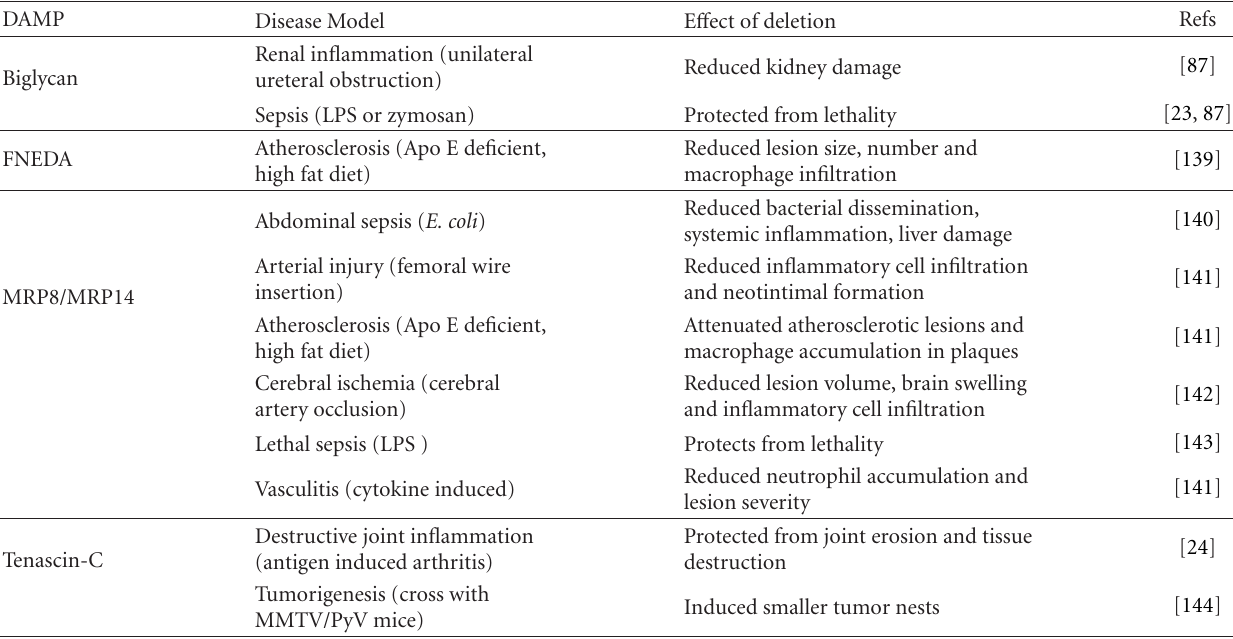
Table 2: Targeted deletion of DAMPs protects from experimental disease . Mice which do not express certain DAMPs exhibit reduced symptoms of inflammatory disease or tumor metastasis in vivo